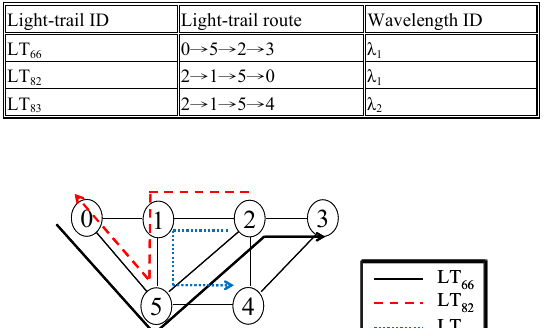
TABLE 5. The established light-trails in the optimal solution for scenario 1